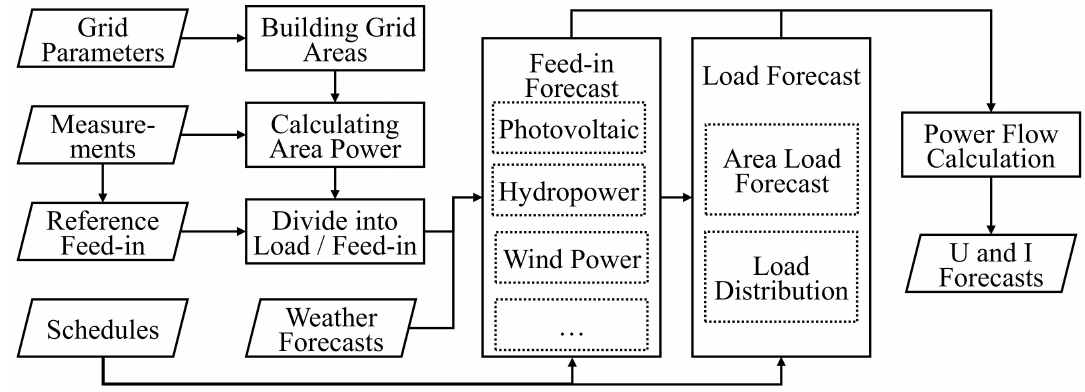
Figure 1. Procedure of a grid state forecast by a bottom-up